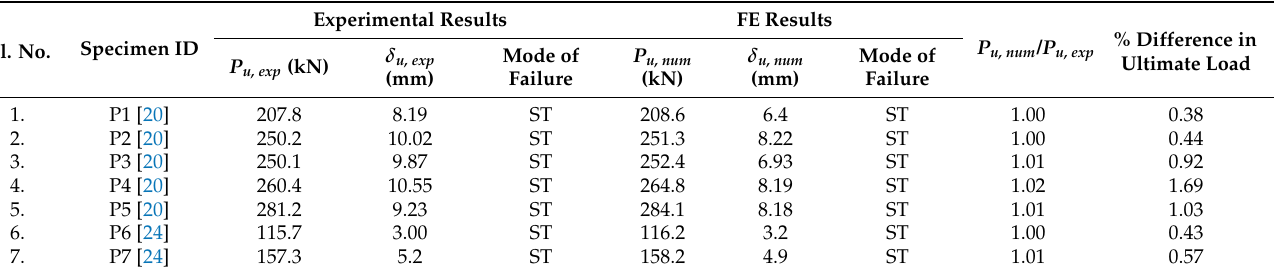
Table 4. Summary of comparative study details.